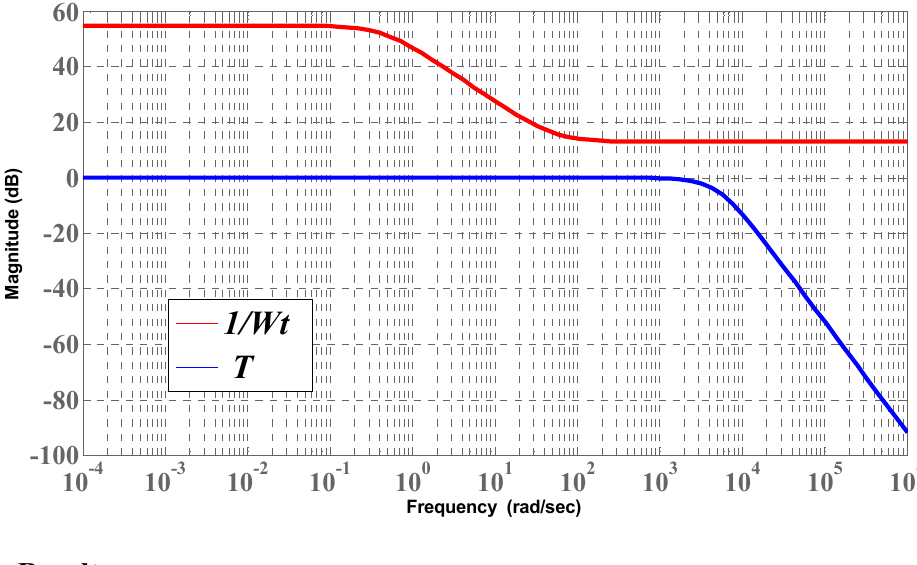
Figure 7. Singular value curves of complementary sensitivity function T